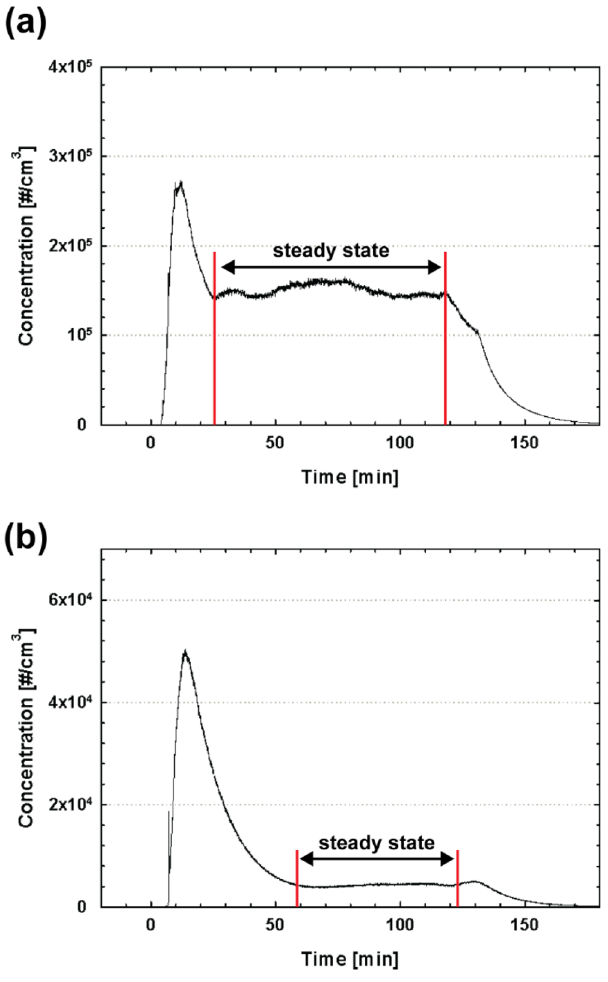
Figure 8. Concentration as a function of time measured using a CPC for ( a ) ABS and ( b ) PLA filaments during two hours of a printing